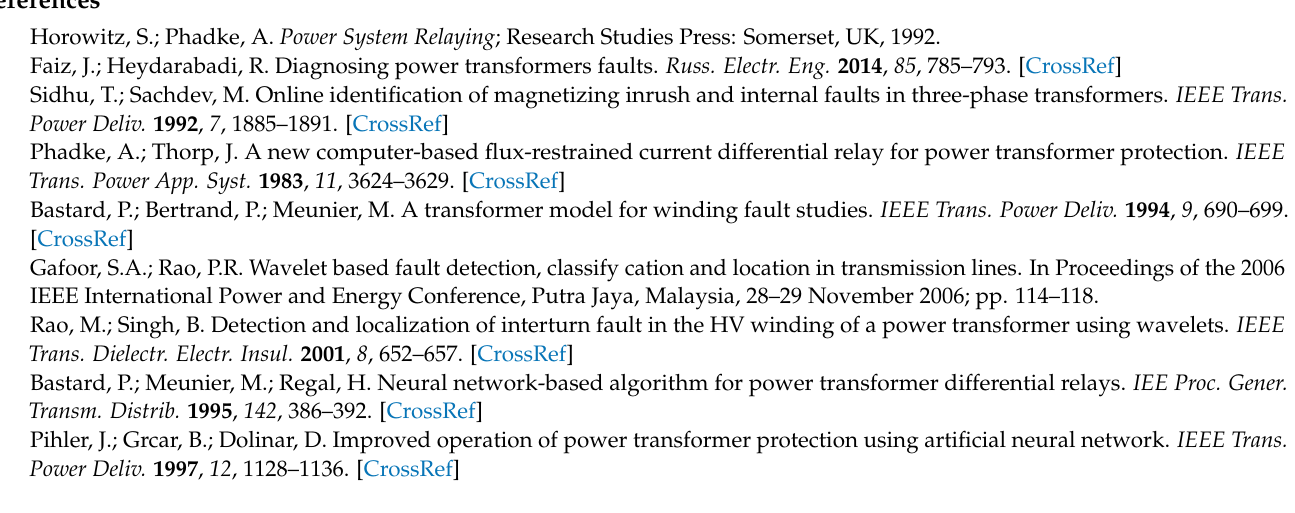
Figure A2. A flow chart of genetic algorithm optimization.